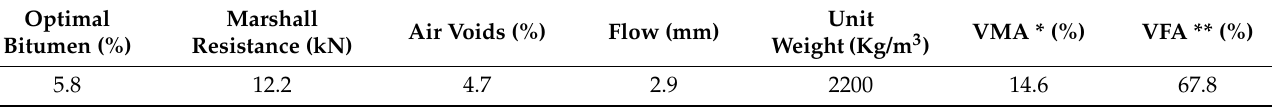
Table 2. Characteristics of manufactured HMA material.